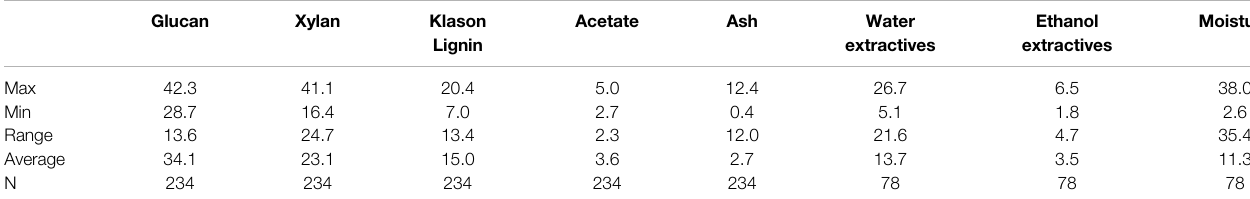
TABLE 1 | Summary ofcompositiondatafor thespecimensanalyzedinthis work. Maximum, minimum, rangeand averagefor chemicals aregiven aswt%on adry basis. N refers to the number of NIR spectra available for correlation with a given parameter. Glucan